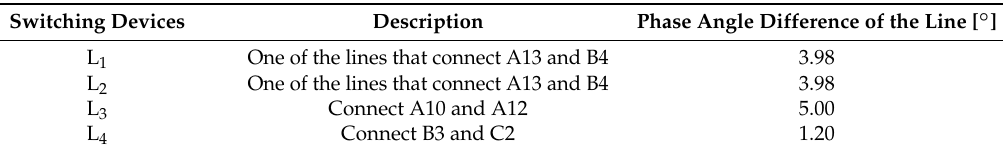
Figure 3. Topology of the power system with under-voltage emergency in Case 2. Four suspended lines are chosen as switching devices, as shown in Table 7. Table 7. Switching devices in Case 2.